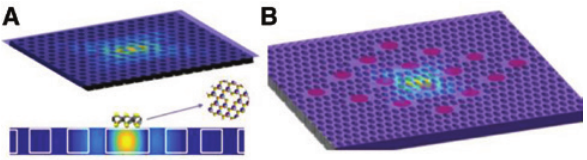
Figure 8: Patterned quantum dots in layered